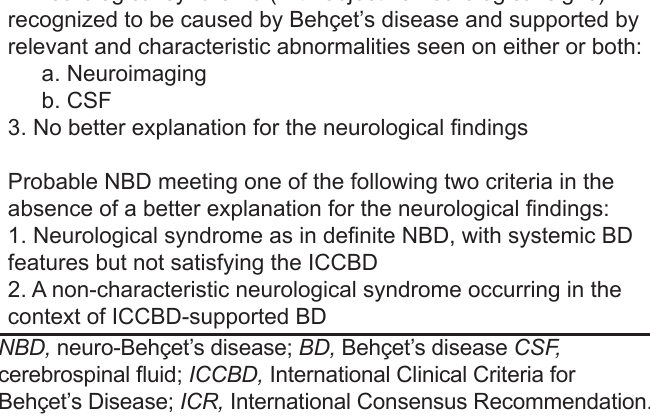
NBD, neuro-Behçet’s disease; BD, Behçet’s disease